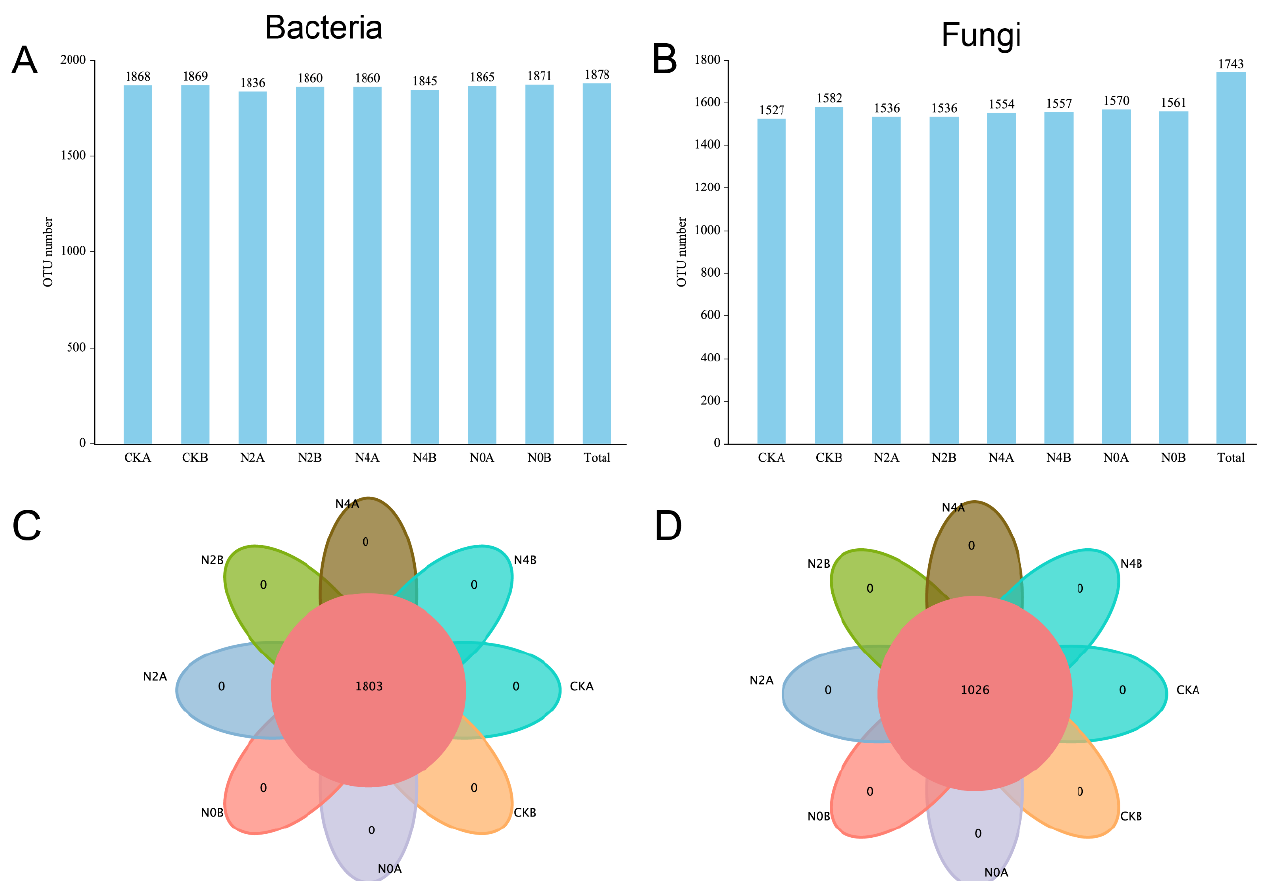
Figure 3. OTU statistics. ( A ) Histogram of bacteria OTUs number in different treatments. ( B ) Histogram of fungi OTUs number in different treatments. ( C ) Venn diagram of bacteria OTUs with different treatments. ( D ) Venn diagram of fungi OTUs with different treatments.